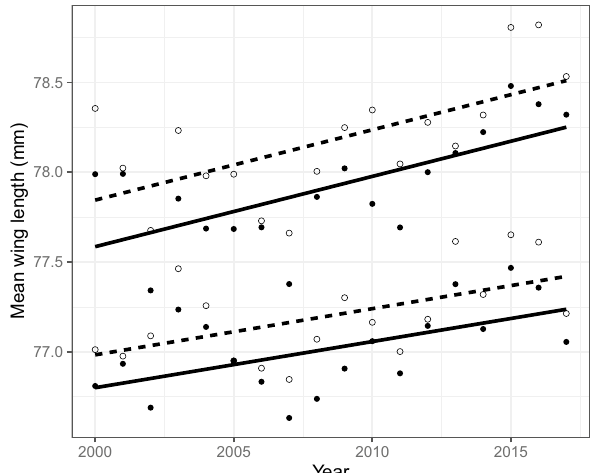
Figure 3. Temporal trend in the wing length of adult blackcaps (open circles denote males, solid circles denote females), captured in Israel during spring migration. Lines were fitted with a general linear mixed effect model (GLMM) with year and sex as explanatory variable, and year also as a random effect for males (dashed line) and females (solid line) in adults (upper lines) and second year birds (lower lines).